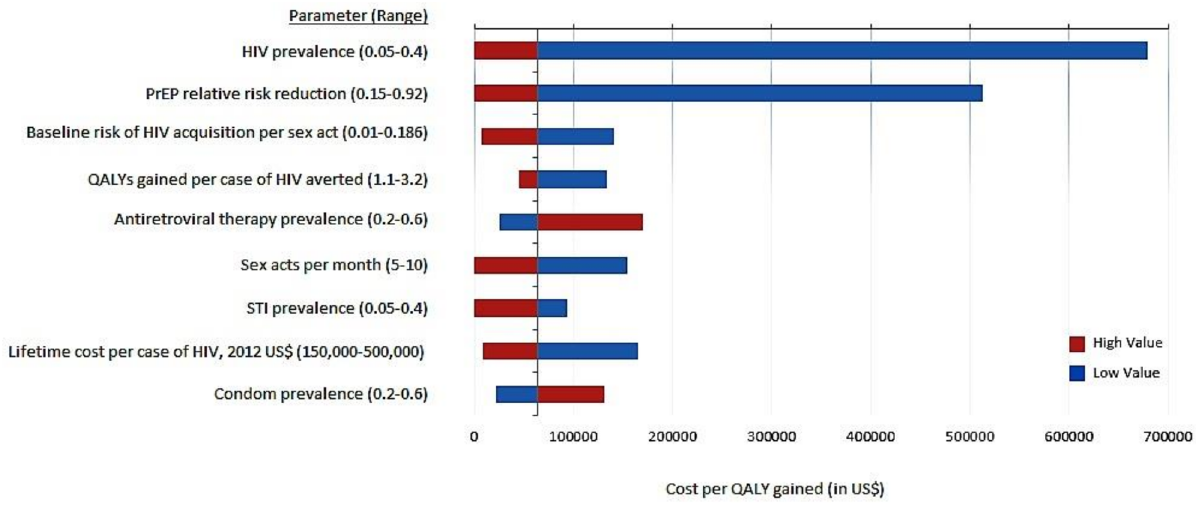
Fig 2. One-way sensitivity analysis of PrEP cost-effectiveness(in US$). The black vertical line represents the base case-scenario relative to no PrEP ($64,000per QALY gained). Blue bars represent the low value of the range, and red bars represent the high value of the range. Bars to the left of the base case scenariorepresent more favorable scenarios.Only parameters which affected the cost-effectiveness ratio by more than 50% in either directionare shown.